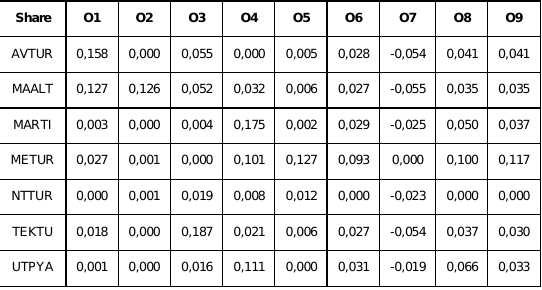
Table 13: 2013 Yearly Negative Ideal Solution Distance Point Share O1 O2 O3 O4 O5 O6 O7 O8 O9